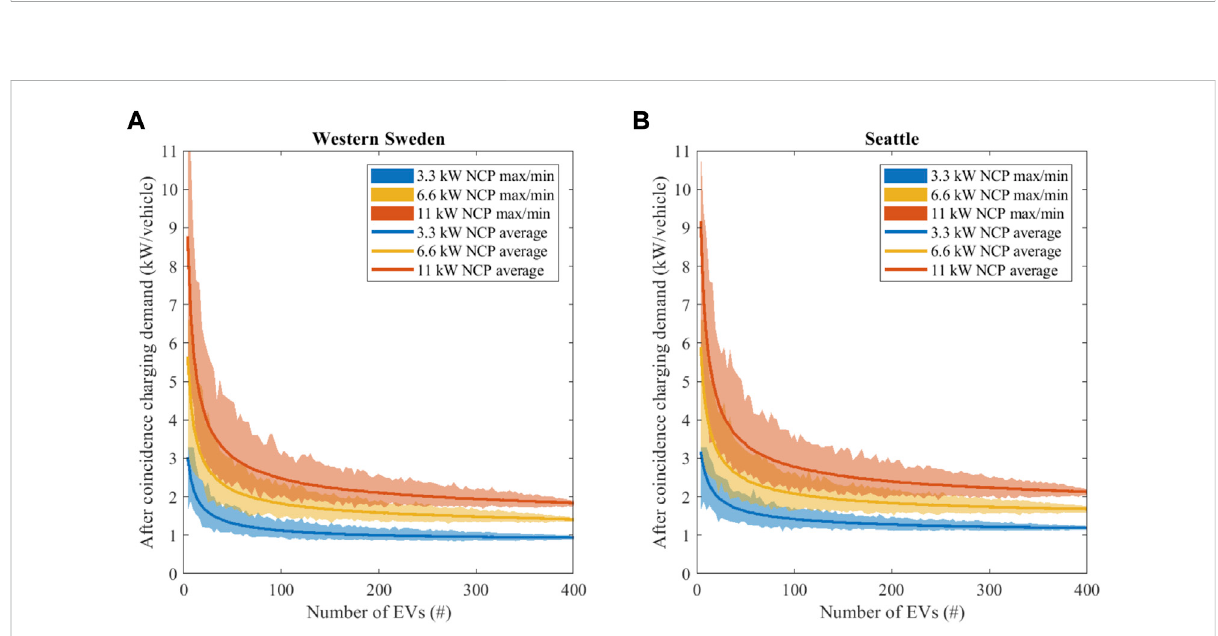
FIGURE 3 After-coincidence charging power demand for the highest hour of the year and as an average for all combination of vehicles with different drivingpatterns.After-coincidencechargingpowerdemandforthreedifferentNominalChargingPowers(NCP).Charginglocationishomeonlyand electricitydemandperkmisassumedtobe0.20 kWh/km.DataforWesternSwedenin (A) andSeattle (B) .Shadedareasshowvariation(maxandmin) from the randomized